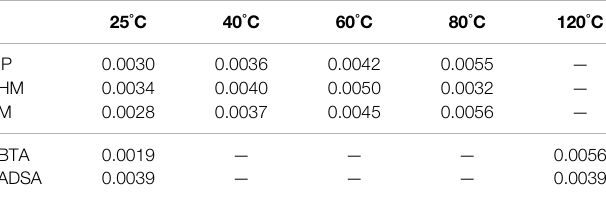
TABLE 4| Probabilitytogeneratesulfenylradicalsobtained byclassical molecular dynamicsimulations( ρ MD